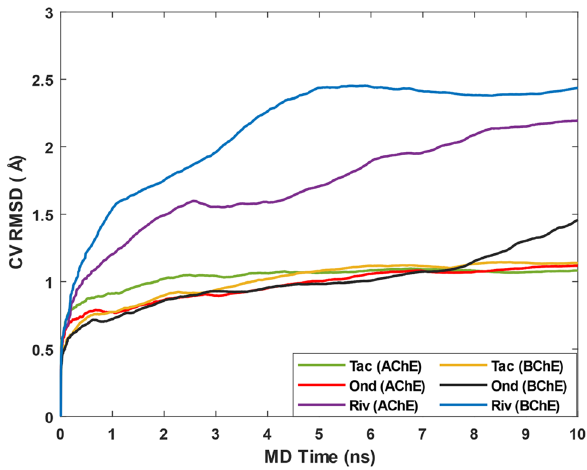
Figure 5. RMSD estimates averaged over 10 BPMD runs vs simulation